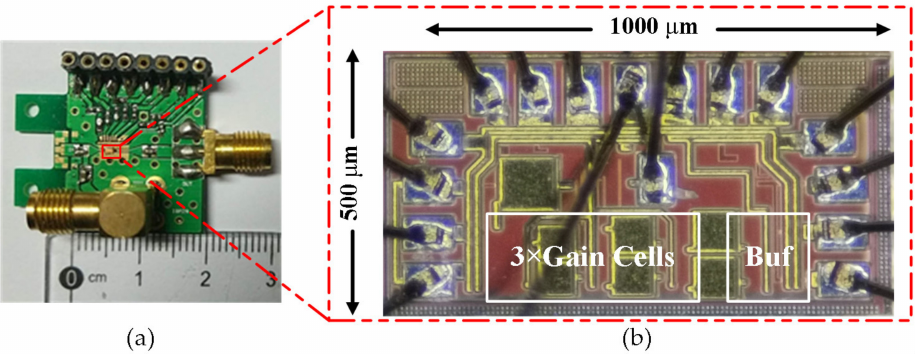
Figure 11. The photograph of PCB test board and the cryogenic amplifier chip: ( a ) The PCB board; ( b ) Chip